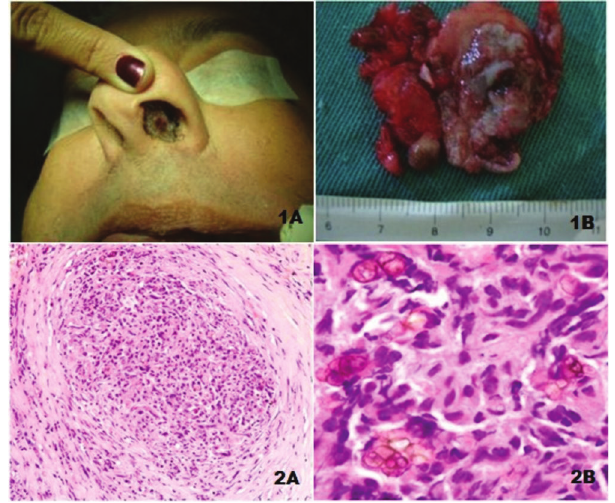
Figure 1 Clinical image of the septal lesion (1A). Lesion removed with mucosal segment (1B). HE, small increase (2A). Chronic granulomatous inflammatory process with rounded and brownish fungi, some with septa. HE, large increase